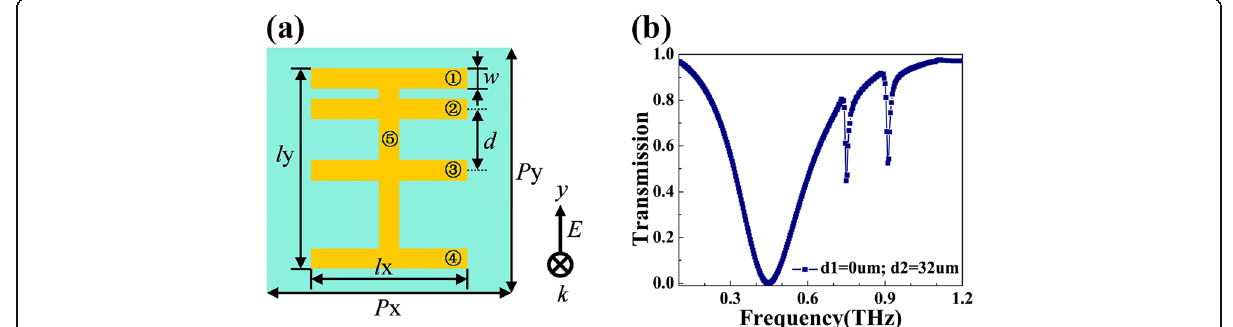
Fig. 6 a Top view of the proposed five-strip structure. b Simulated transmittance curve of the five-strip